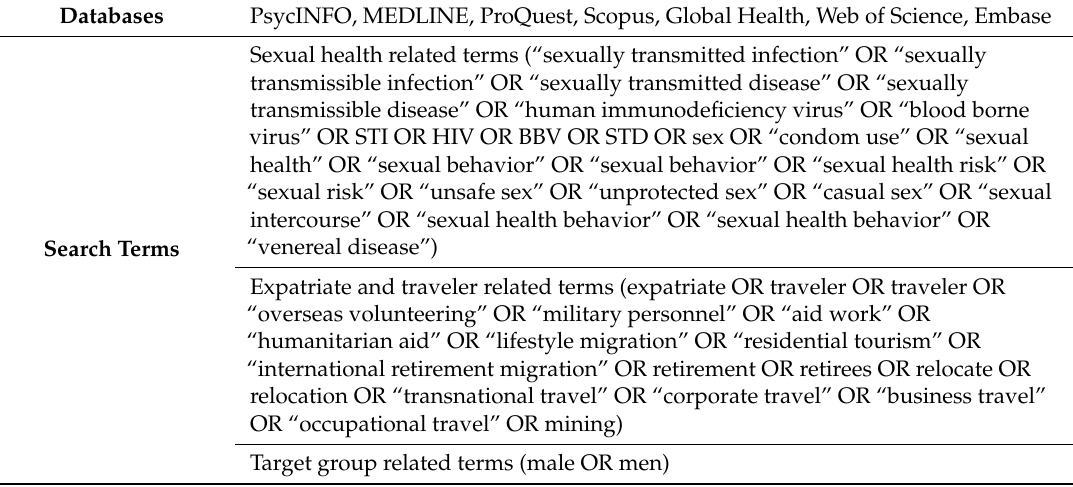
Table 1. Search terms and databases used in the systematic